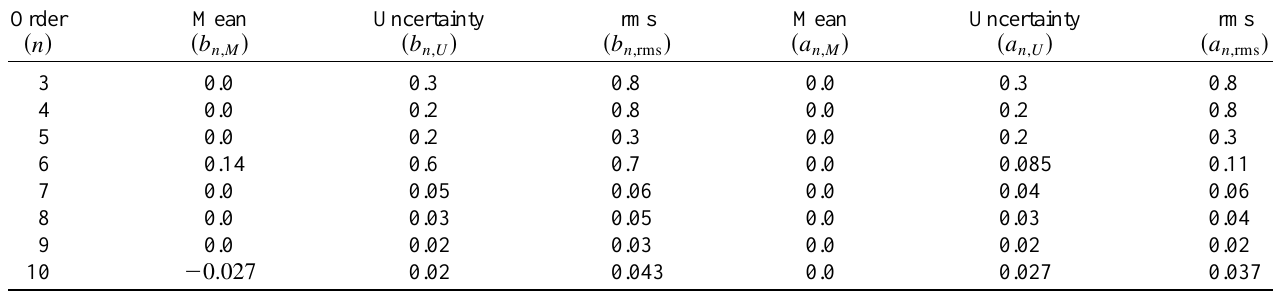
TABLE II. Harmonic multipole content in low- b quadrupoles (Fermilab design), after application of tuning shim correction [13,14]. The harmonic values are quoted in units of 10 2 4 of the main quadrupole field, for a reference radius r 0 (cid:1) 17 mm. The uncertainty in the mean, as well as the estimated standard deviation, is also